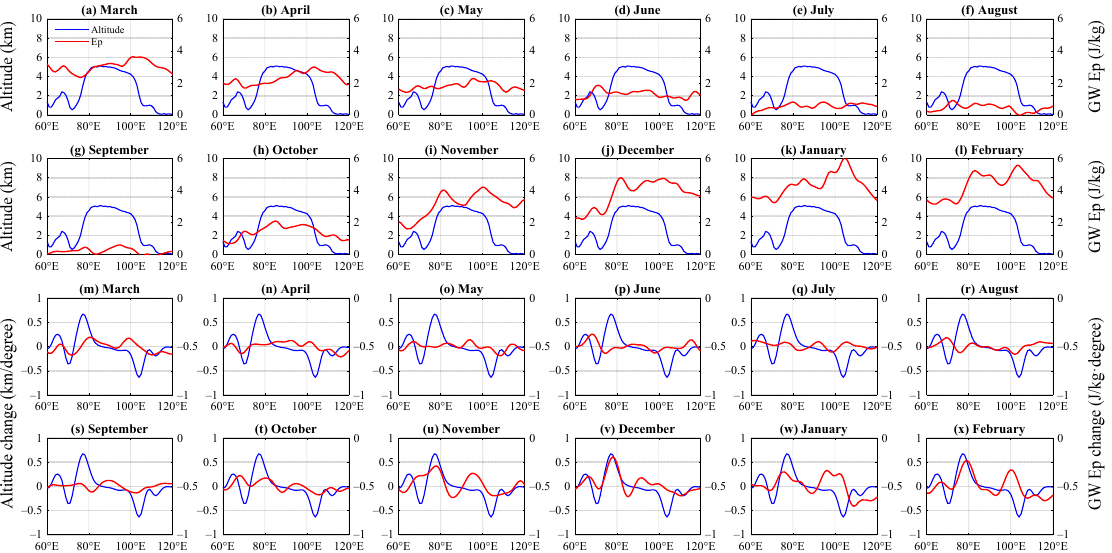
Figure 9. The meridional change and the meridional change rate of monthly mean GW Ep and the elevation from August 2006 to September 2020. Latitude from 30 to 35 ◦ N, longitude from 60 to 120 ◦ E. The red line represents the 18~20 km GW Ep and the blue line represents the